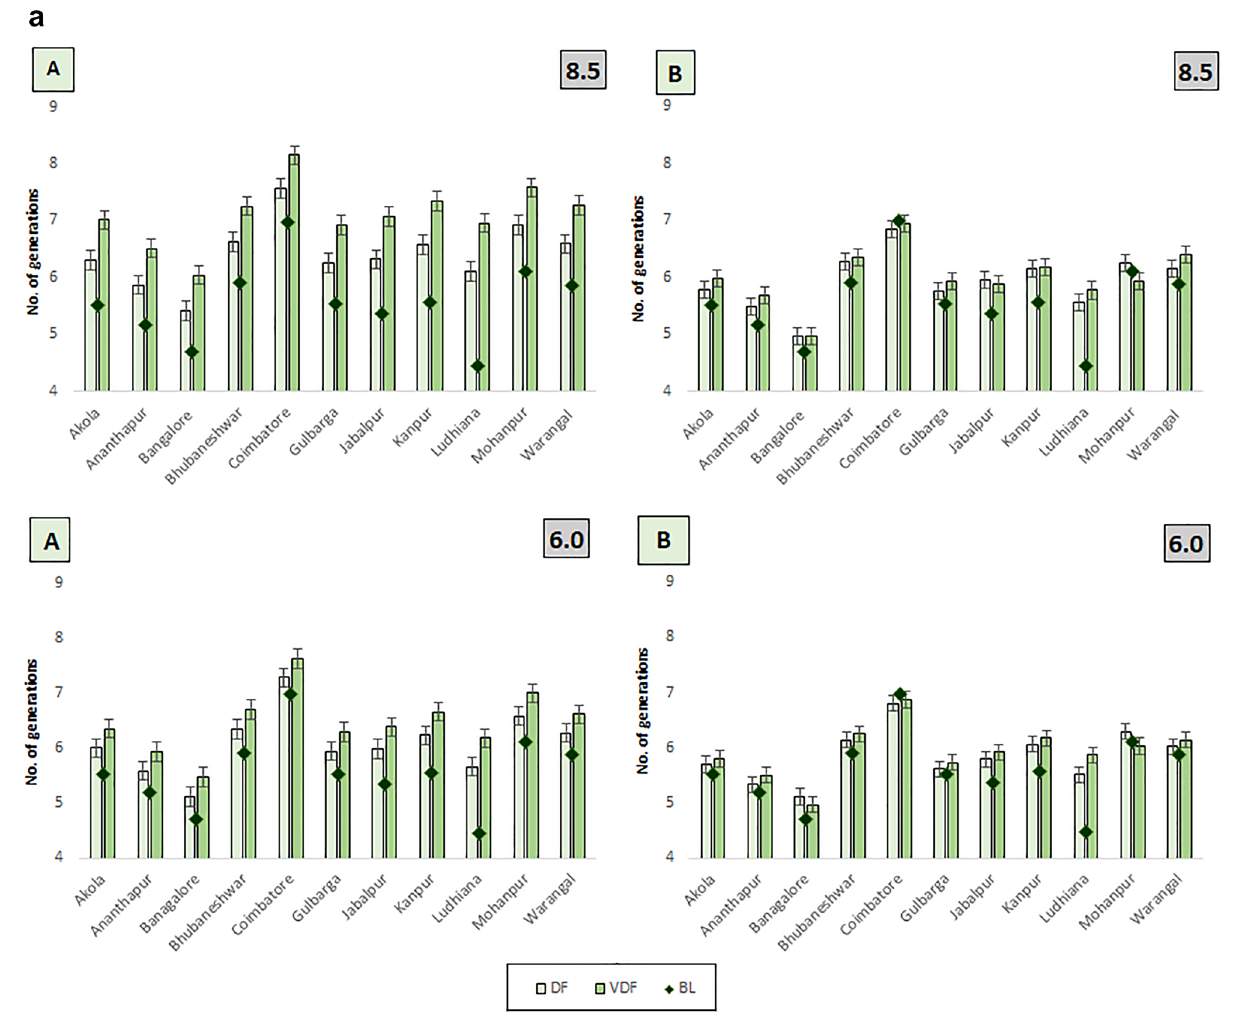
Figure 9. ( a ) Variation in the number of generations with altered duration in LDP during CCPs in 4 RCPs across different locations of India. ( b ) Variation in the number of generations with altered duration in MDP ( b ) during CCPs in 4 RCPs across different locations of